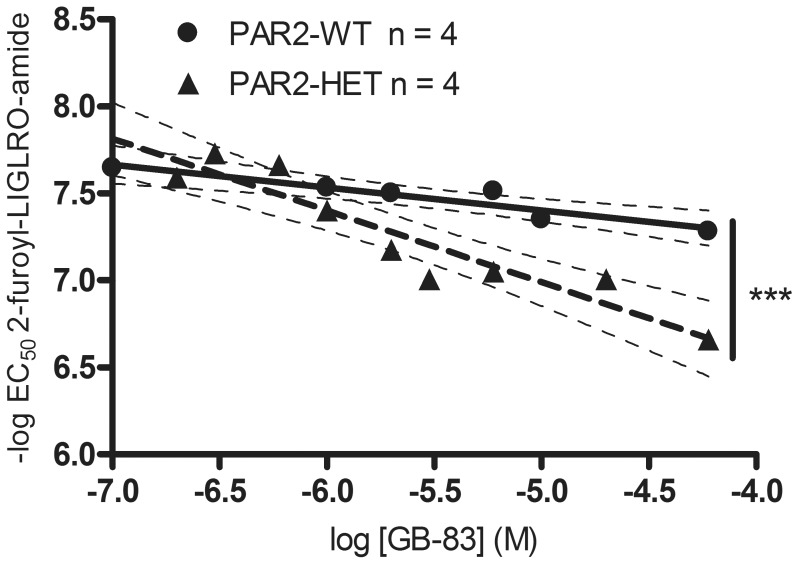
Differential inhibition by protease-activated receptor 2 antagonist GB-83 of 2-furoyl-LIGRLO-amide (2fly)-mediated relaxations of aortas from male PAR2-WT and PAR2-HET.Aortic rings were incubated for 20 min with either vehicle (controls; DMSO 0.1% (v/v) water) or GB-83 (0.1 µM–60 µM) and then cumulative 2fly concentration-relaxation response relationships were constructed in aortas, submaximally contracted by addition of phenylephrine (0.7 µM). Thick lines indicate simple linear regression analyses of 2fly EC50 values (symbols; log transformed) versus concentration of antagonist GB-83 (log transformed); thin dashed lines indicate S.E.M for each regression line. n = number of mice. ***P<0.001, slope regression coefficient of PAR-WT compared to PAR2-HET by Student's t-test. Coefficient of determination (R2) was 0.88 in both strains; *P<0.05, slopes for PAR2-WT and PAR2-HET compared to 0, and WT vs. HET. 2fly -log EC50 values of controls were 7.25±0.05 in PAR2-WT and 7.43±0.02 in PAR2-HET.